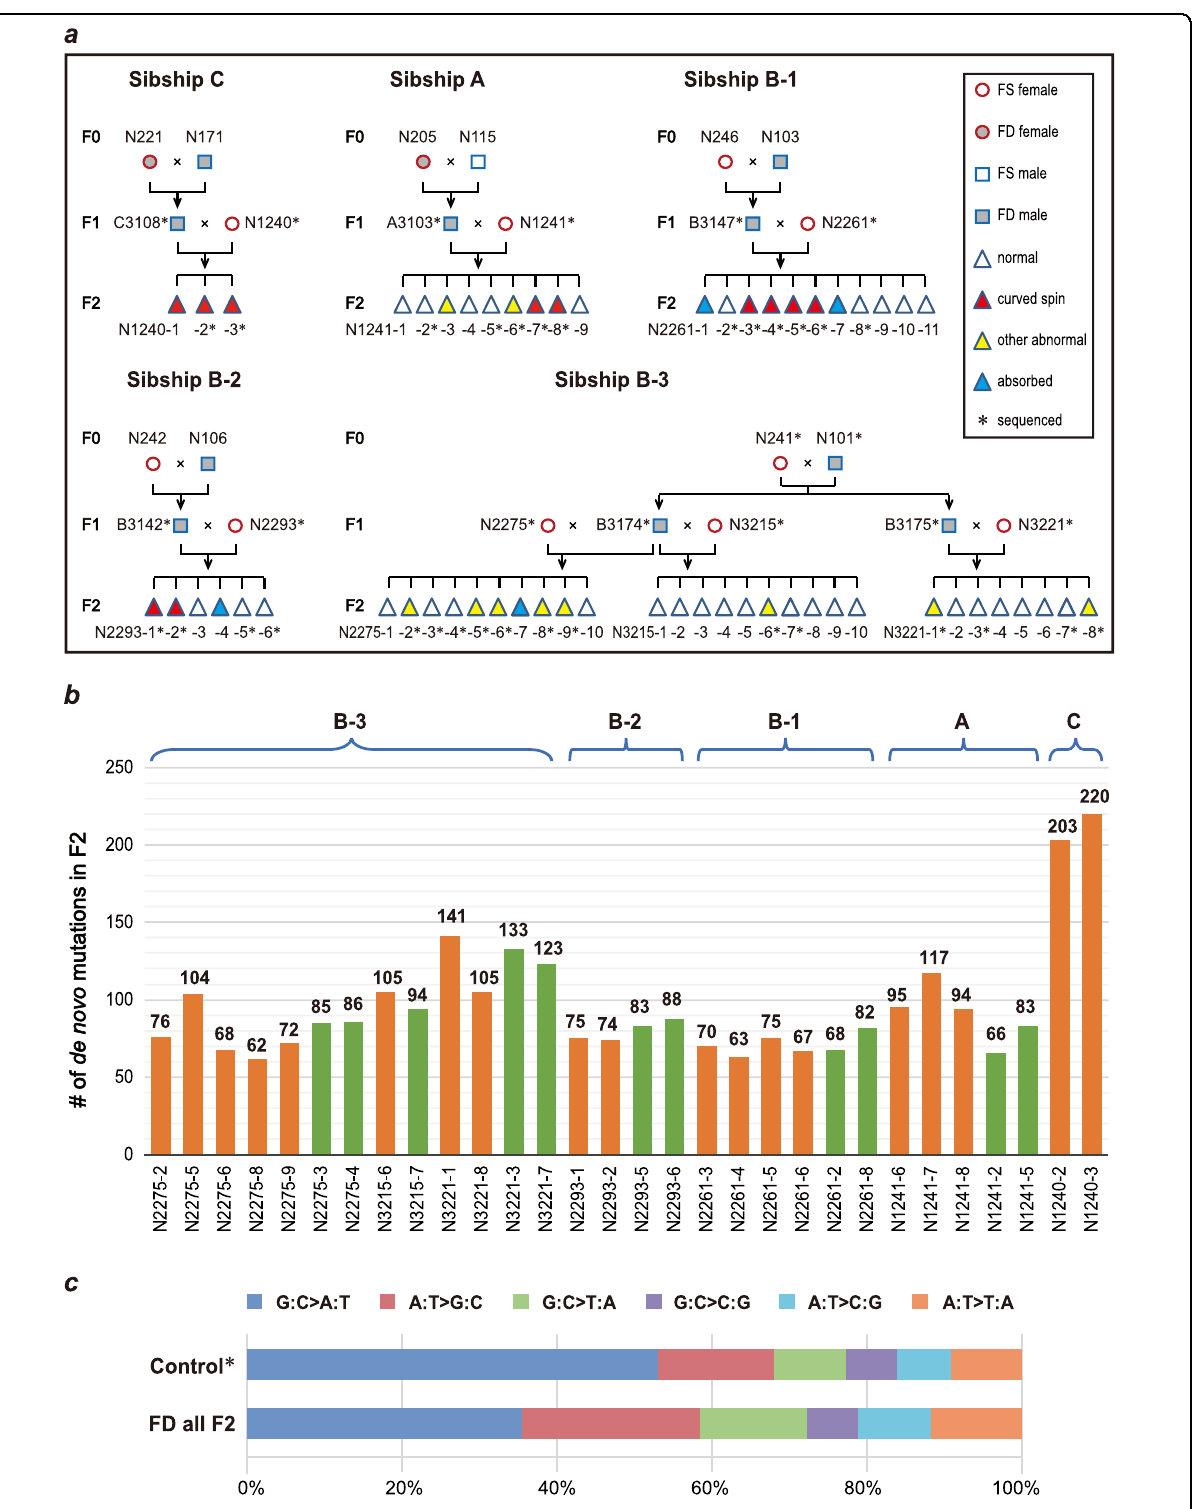
Fig. 3 The FD diet in two generations signi fi cantly increased DNMs in F2 embryos. a Illustration of sibship relationships of the samples selected for whole-genome sequencing. b The DNMs in F2 progenies in these sibships. Samples exhibit malformations are orange, while those showing normal phenotypes are green. The average number of mutations in the A, B and C sibship are 91, 87, and 211, respectively. c Illustration of mutation spectra of those DNMs observed in all F2 embryos. *The control data were adopted from previous reports 22 – 24